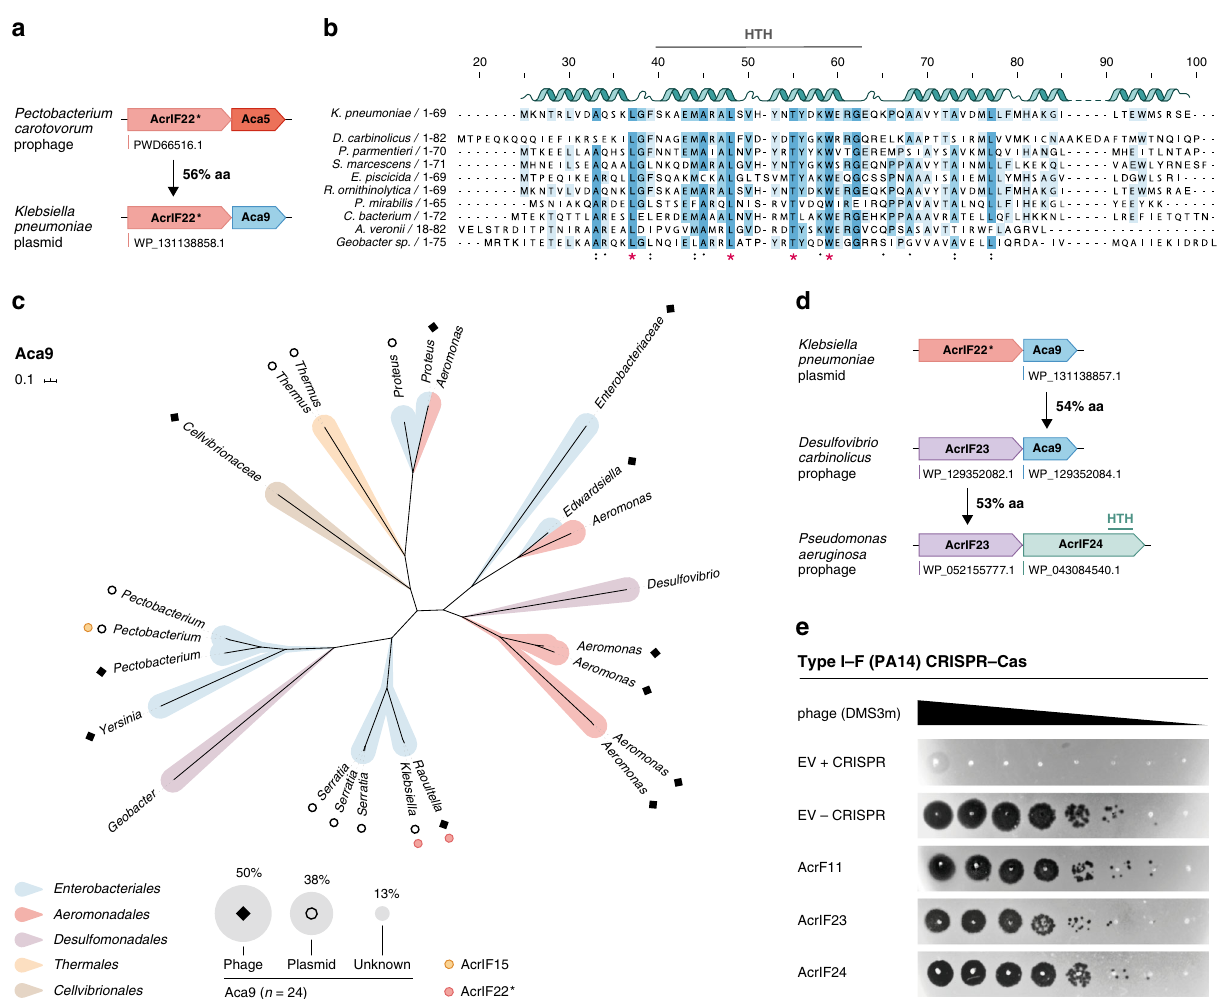
Fig. 5 Discovery of Aca9 uncovers two potent I – F Acrs. a Identi fi cation of an AcrIF22* homolog reveals a previously undescribed aca marker gene ( aca9 ). b Alignment of diverse Aca9 representatives carried by Proteobacterial MGEs. Predicted secondary structure alpha-helix regions are illustrated as ribbons for the K. pneumoniae homolog (top). The HTH DNA-binding domain is highlighted in gray. c Phylogenetic diversity of Aca9 across publicly available sequences. Tree branches are colored by the bacterial host from where they originate (Order level). The MGE origin is shown with an empty circle (plasmid-like elements), a black diamond (phage), and left blank when the genomic context was unclear. The relative percentage distribution of aca9 orthologs by MGE origin is depicted as the area of the gray shaded circles in the legend. The positions in the tree where acrIF15 and acrIF22* are found associated with aca9 are marked with yellow and red circles, respectively. d Guilt-by-association searches following aca9 led to the discovery of two candidate acr genes in P. aeruginosa . e Functional testing for inhibition of the PA14 I – F CRISPR – Cas system was performed by phage plaque assays in strains carrying plasmids expressing the indicated acr candidates. Ten-fold serial dilutions of CRISPR-targeted DMS3m phage were titered on lawns of P. aeruginosa naturally expressing its I – F CRISPR – Cas system. The Δ CRISPR strain shows phage replication in the absence of CRISPR – Cas targeting. AcrIF11 was employed as a positive control for strong I – F inhibition. Source data are available in the Source data fi